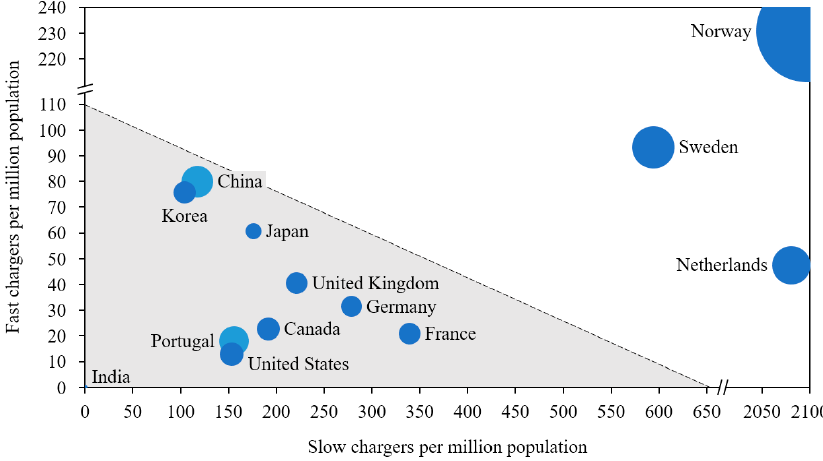
Figure 2. EV market share and policy incentives in 2018.